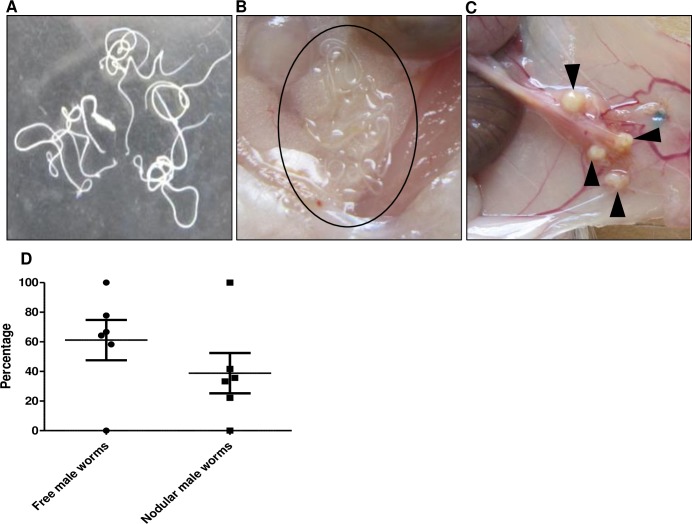
Recovery of free or nodular O. ochengi adult male worms within the peritoneum of gerbils.A) Liberated O. ochengi adult male worms in vitro from worm masses removed from infected cattle skin, B) Cluster of free O. ochengi adult male worms in the peritoneum of gerbils (circle) 35 days post-implantation, C) Nodules containing O. ochengi adult male worms in the peritoneum of gerbils (arrow head) 35 days post-implantation, D) Percentage of free and nodular O. ochengi adult male worms in the peritoneum of gerbils 35 days post-implantation. Analyses showed that 61.2 ± 13.6% of the male worms recovered were free in the peritoneum while 38.8 ± 13.6% were in nodules (Fig 3D). There was no statistically significant difference in the motility of male worms recovered from nodules or found free in the peritoneum of control groups (S1 Table). Eighty nine (89)% of the O. ochengi male worms recovered from the exploratory gerbils scored 100% motility.